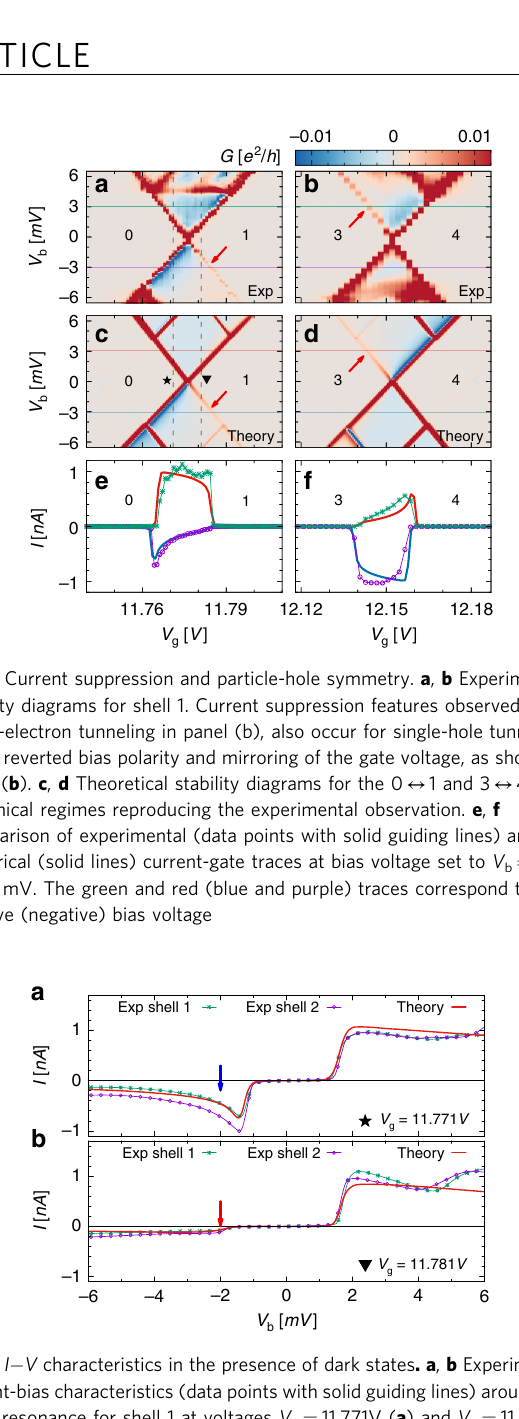
sequential tunneling regime are a tunneling Hamiltonian cou- isolated system in the energy range set by the electrochemical potentials of the lead electrodes. The presence of orbital degen- eracies (or quasi-degeneracies) is decisive for the occurrence of